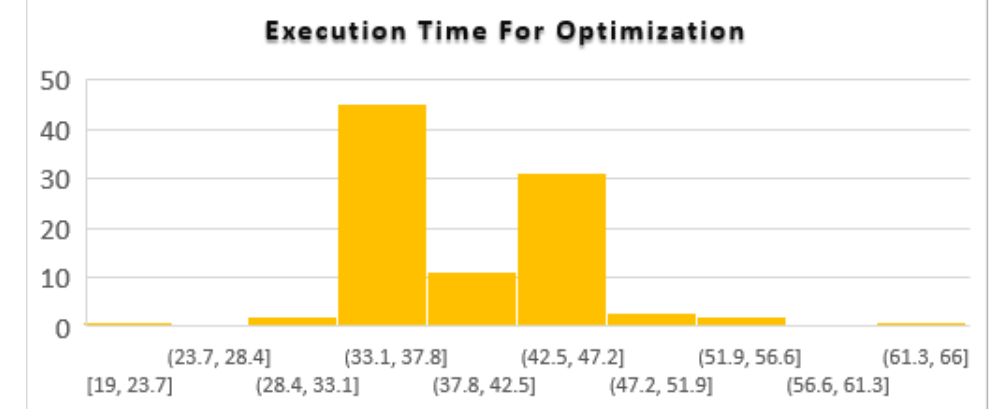
Figure 11. Results of Optimization Engine Execution Time for Environment Optimization.